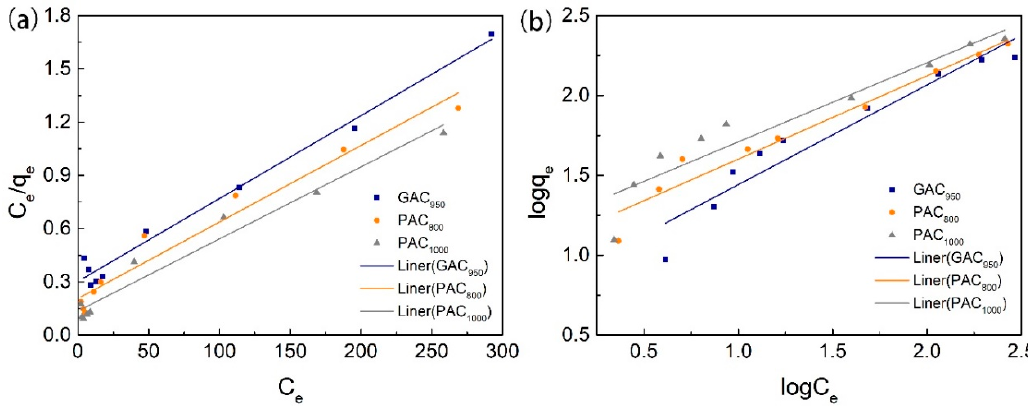
Figure 6. E ff ects of the initial phenol concentrations on the adsorption on ( a ) GAC 950 , ( b ) PAC 800 , Figure 6. Effects of the initial phenol concentrations on the adsorption on (a) GAC 950 , (b) PAC 800 , and and ( c ) PAC 1000 . (c) PAC 1000.